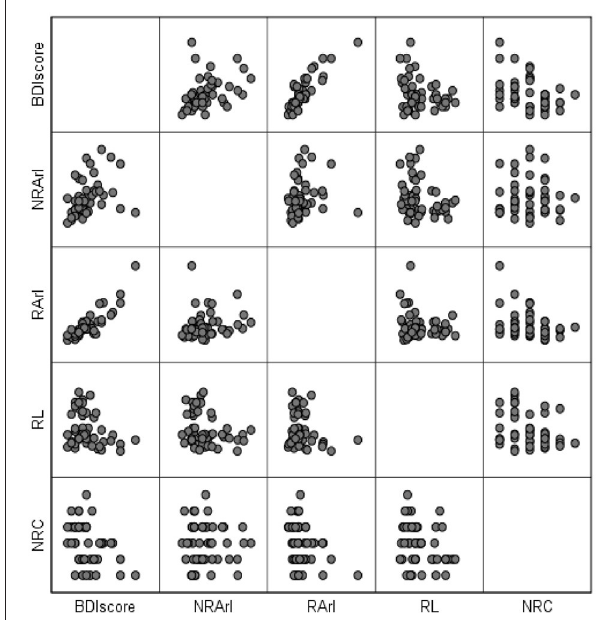
FIGURE 1 | Matrix scatterplot between BDI scores (after 3 months of follow-up) and structural variables of rapid eye movement sleep after 3 months